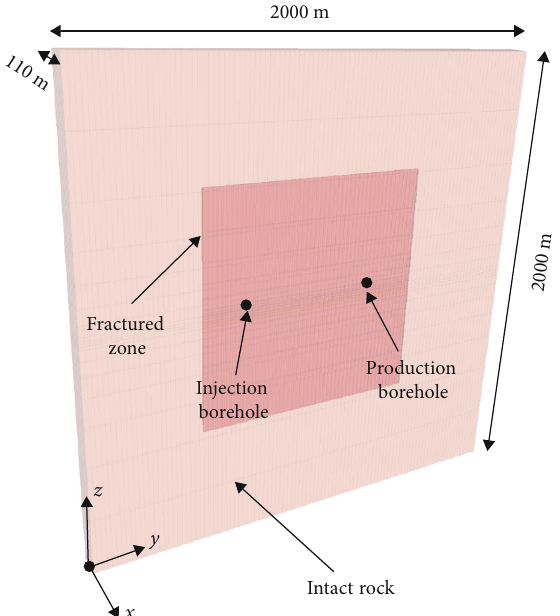
Figure 4: Thermo-hydro-mechanical (THM) model implemented within the framework of TOUGH-FLAC.